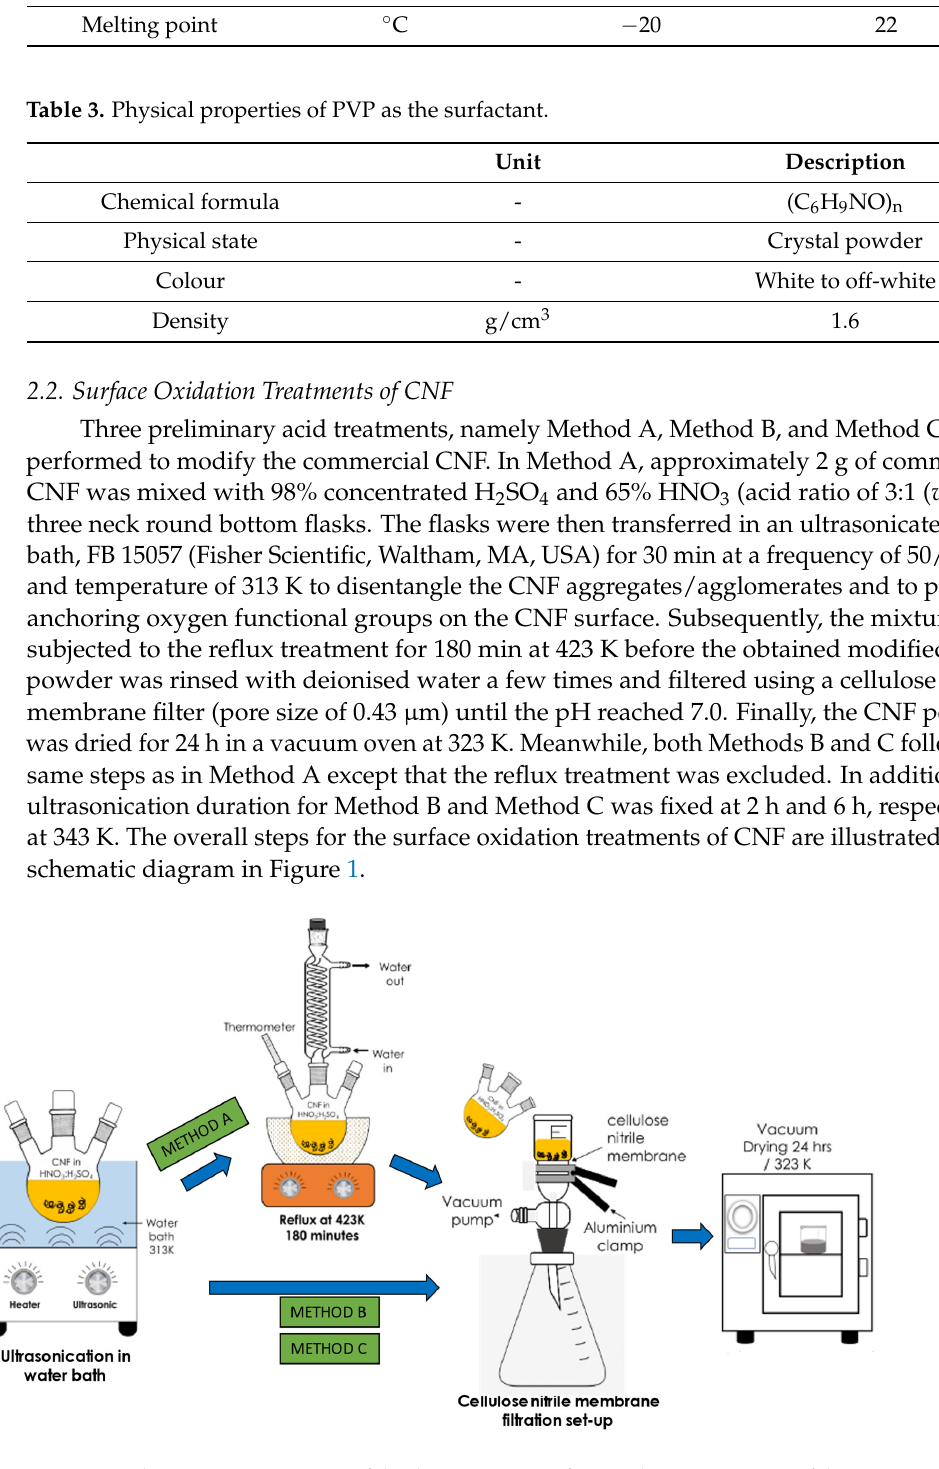
Figure 1. Schematic representation of the three varying surface oxidation treatments of the commer ‐ cial